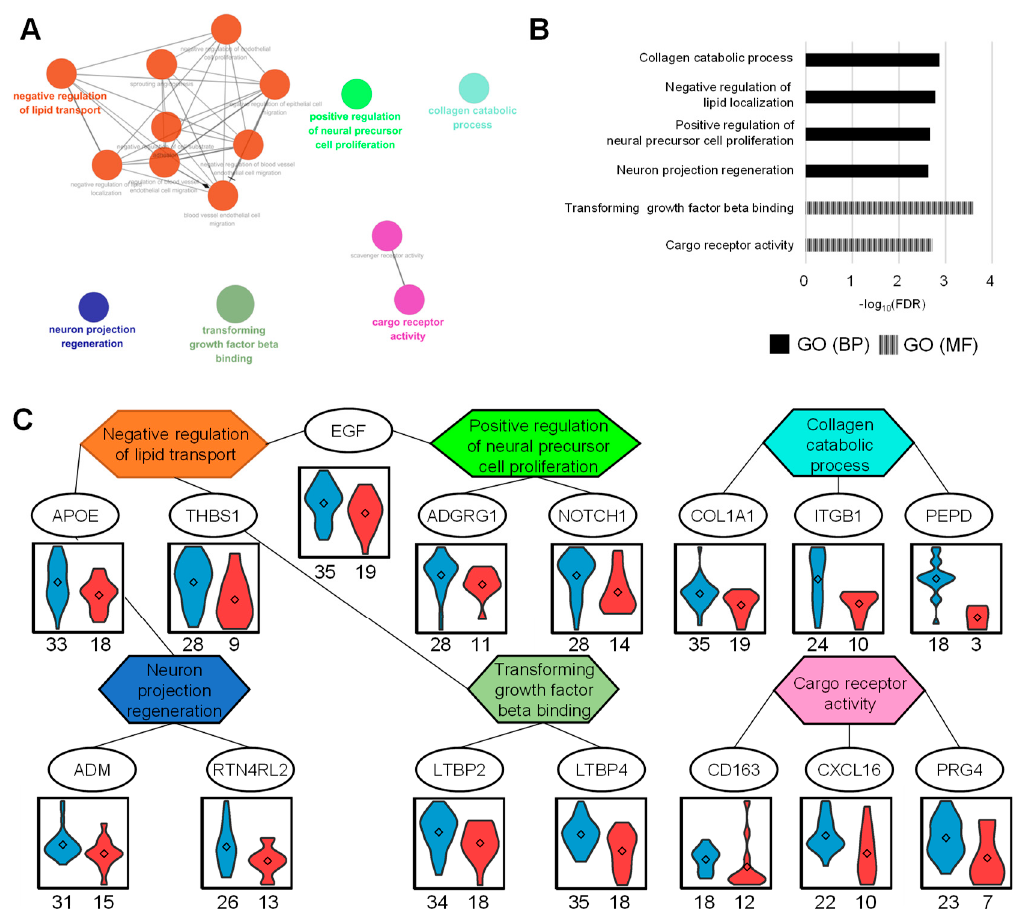
Figure 3. Up-regulated proteome in good prognosis group (GPG) and gene ontology (GO) analysis. ( A ) Functional GO network displaying grouping of GO terms enriched in GPG up-regulated proteins. ( B ) Enriched GO terms in biological process and molecular function. ( C ) The network between GO terms and corresponding proteins represents the relationship between GO terms via the proteins. The abundances of each protein represent the violin plots in two groups. The numbers listed below represent the measured numbers for each group.